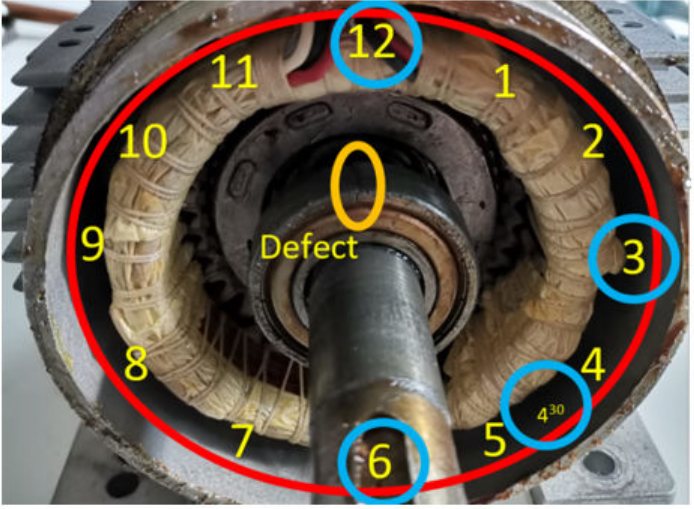
Figure 4. The different hour locations of the single-point defect analyzed. The crack positions considered are circled in light blue.